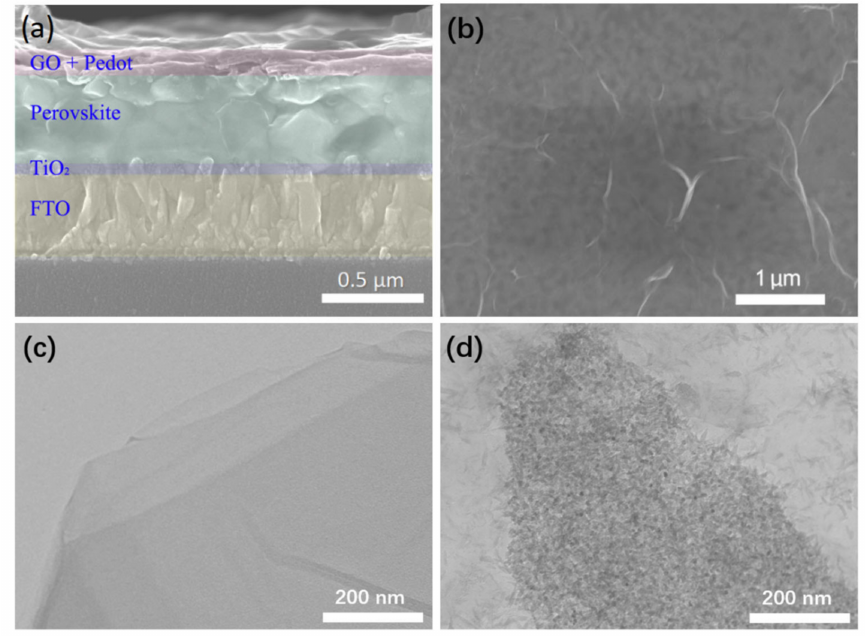
Figure 2. ( a , b ) SEM images of the device ( c ) TEM images of GO ( d ) TEM images of PEDOT-GO. In order to investigate the optimum component, samples with PEDOT/GO ratio as 0, 0.5, 0.75, 1 were prepared and tested, respectively. Figure 3a is the J–V curves of the mesoporous PSCs with different mass ratio PEDOT-GO composite films. The FTO/cp- TiO 2 /MAPbI 3 /C structure of PSC was fabricated as a control group compared with FTO/cp-TiO 2 /MAPbI 3 /PEDOT-GO (or spiro-OMeTAD)/C structure. Figure 3b shows the Nyquist plots and the equivalent circuit model of the PSCs [23]. The high frequency arc is reflected to the hole transport and extraction between the PEDOT-GO and the carbon cathode; the low frequency arc shows charge recombination of PSCs